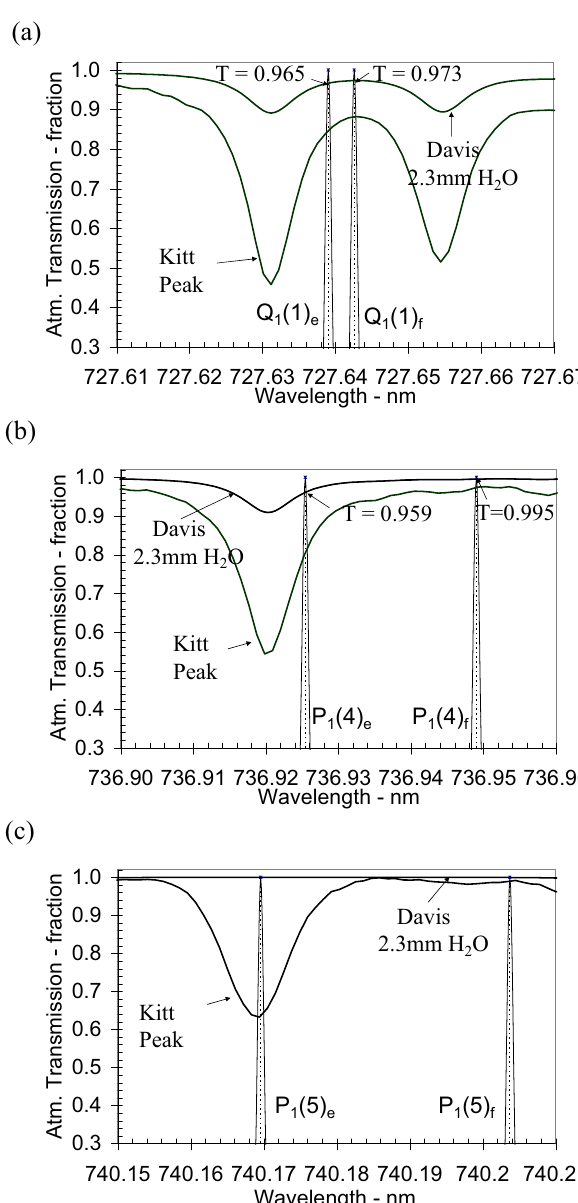
Fig. 4. An expansion of the OH(8–3) Q 1 (1), P 1 (4) and P 1 (5) spec- tral regions, showing the Kitt Peak combined solar and telluric, high-resolution spectrum and a pressure-broadened, water vapour spectrum for typical Davis winter conditions (2.3mm H 2 O, HI- TRAN 2001 line parameters). The hydroxyl line e and f compo- nents are shown with appropriate Doppler broadening (after Espy and Hammond,